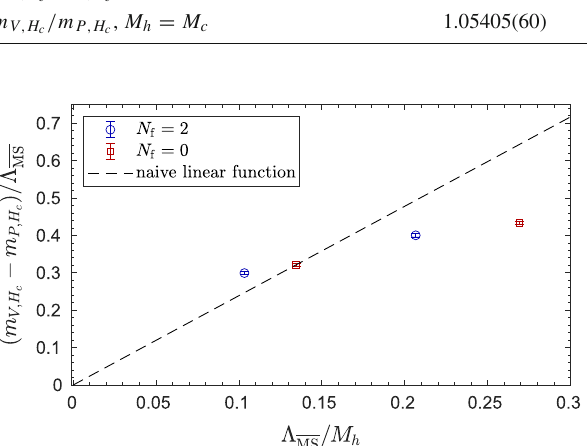
Fig. 7 The hyperfine splitting of heavy-charm mesons as a function of the inverse RGI heavy quark mass for N f = 2 (blue circles) and N f = 0 (red squares) QCD. The dashed line is a linear function which passes through the N f = 0 points at infinite quark mass and M h = 2 M c , and it has been extended to smaller quark masses